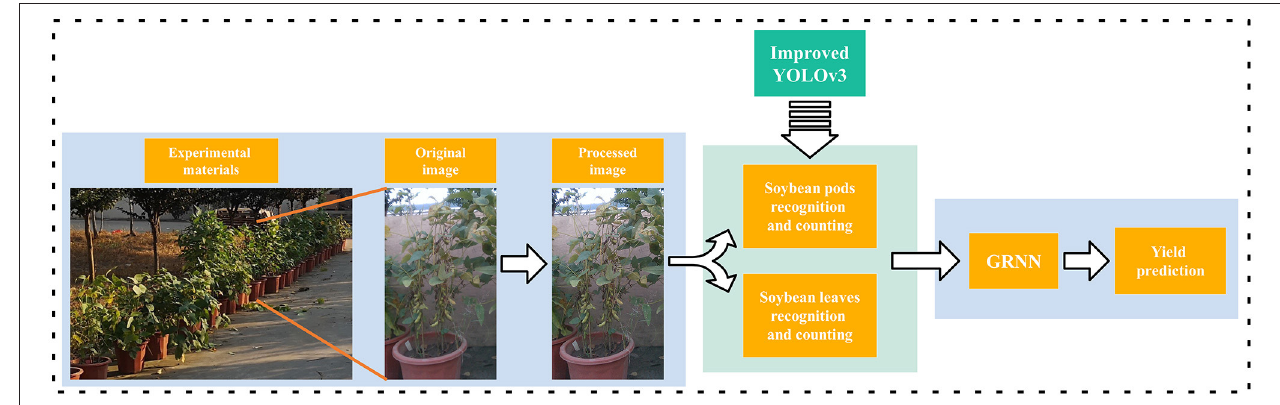
FIGURE 1 | Flowchart of the soybean yield prediction